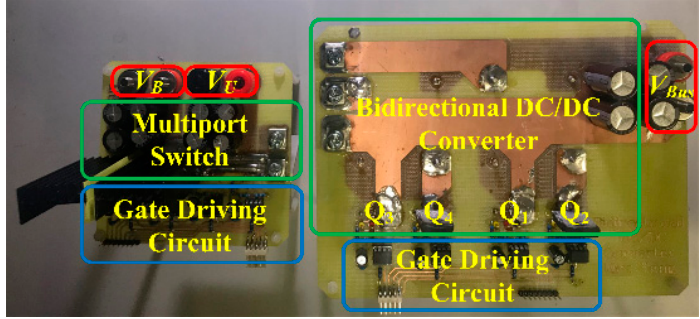
Figure 11. Prototype circuit of the proposed converter.